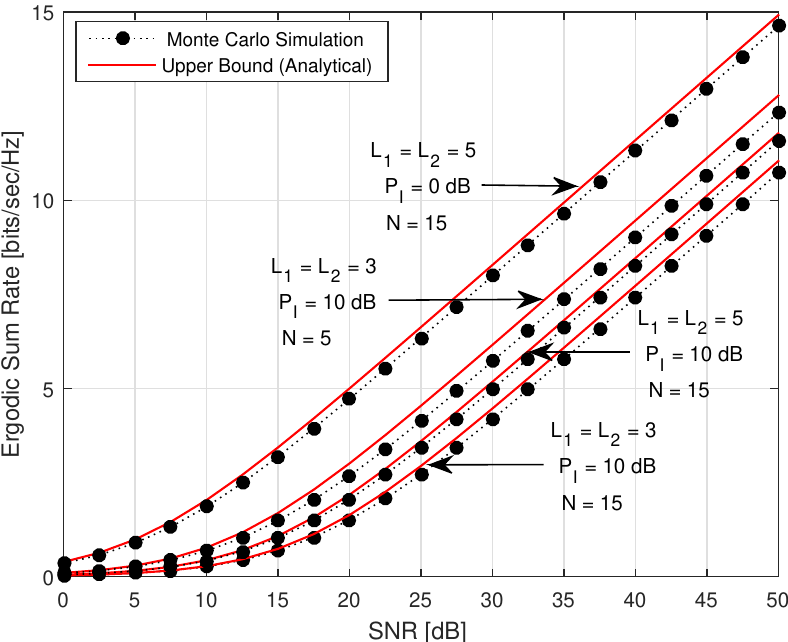
Figure 8. Achievable sum rate with different numbers of CCI Signals, power and different number of